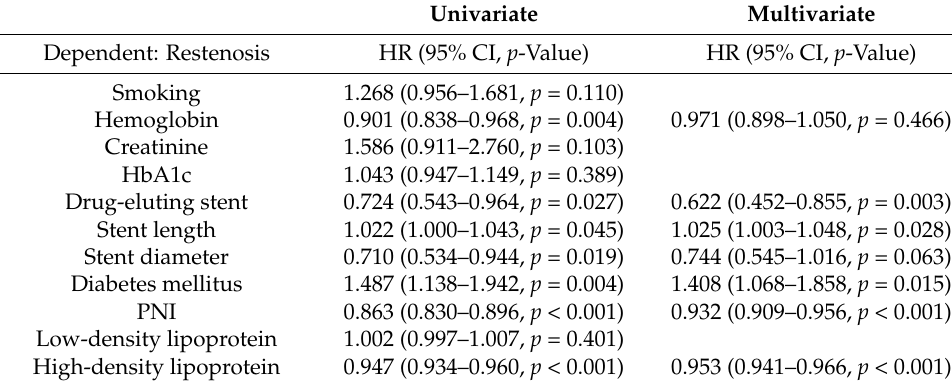
Table 3. Cox proportional hazard model for predicting the development of